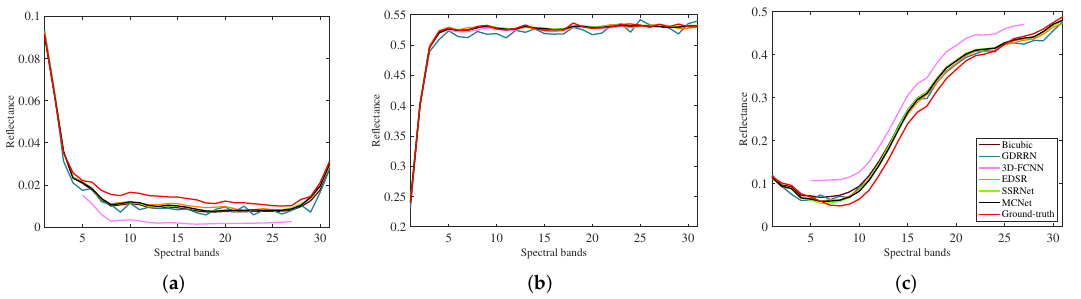
Figure 10. Visual comparison of spectral distortion for image fake_and_real_lemons on CAVE dataset. ( a – c ) Results of the spectral curve in pixel position (20, 20), (100, 100), and (340, 340).